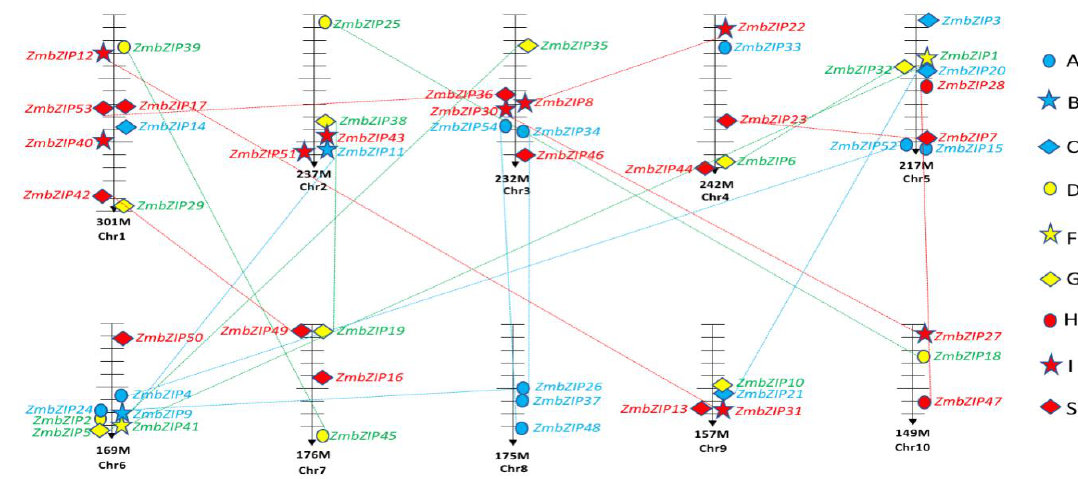
Figure 4. Chromosomal locations of maize bZIP genes. Chromosome numbers and the physical position (M) are shown at the bottom of each vertical gray bar. The segmental duplication gene pairs are joined by corresponding color lines. Different ZmbZIP groups are represented by different shapes and colors.